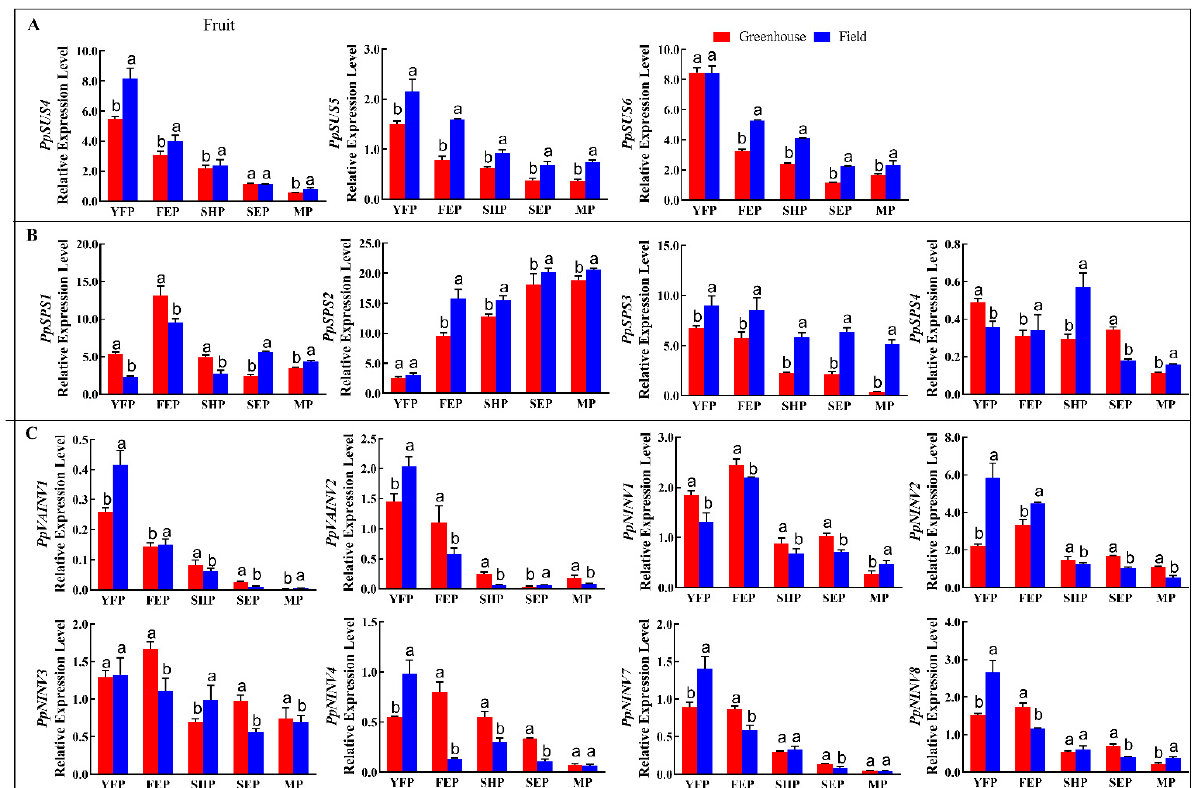
Figure 8. Expression levels of sucrose metabolism-related genes in fruits from plants grown in field and greenhouse environments. ( A – C ) show the expression levels of SUS, SPS and INV-related genes, respectively. The data are presented as the means ± SDs from three biological replicates. Different lowercase letters indicate significant differences ( p < 0.05).